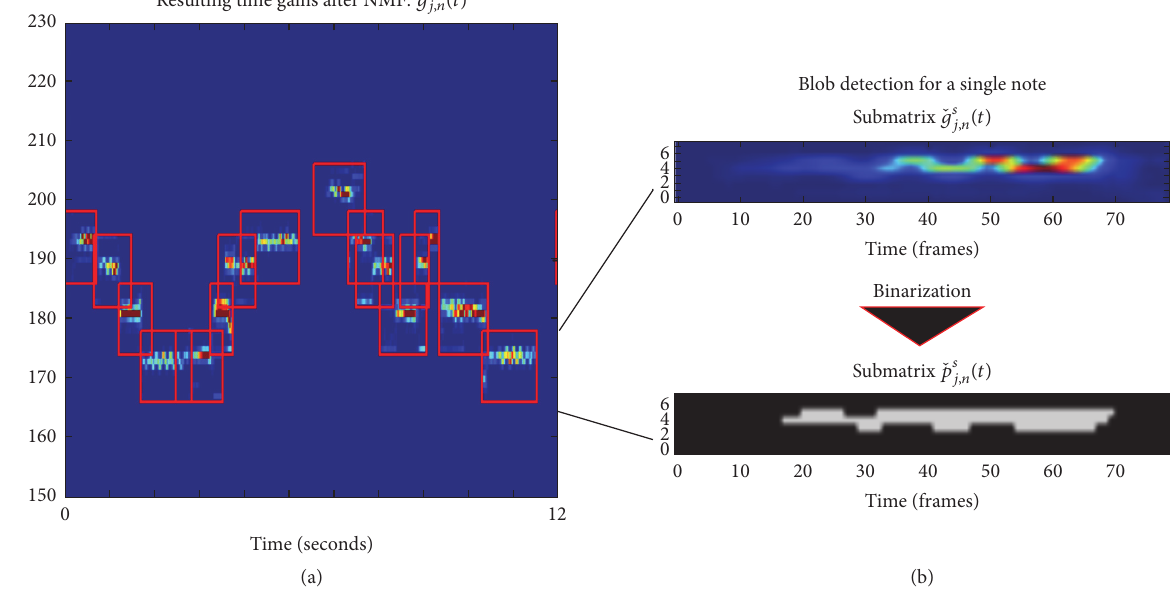
Figure 2: After NMF, the resulting gains (a) are split in submatrices (b) and used to detect blobs [11].